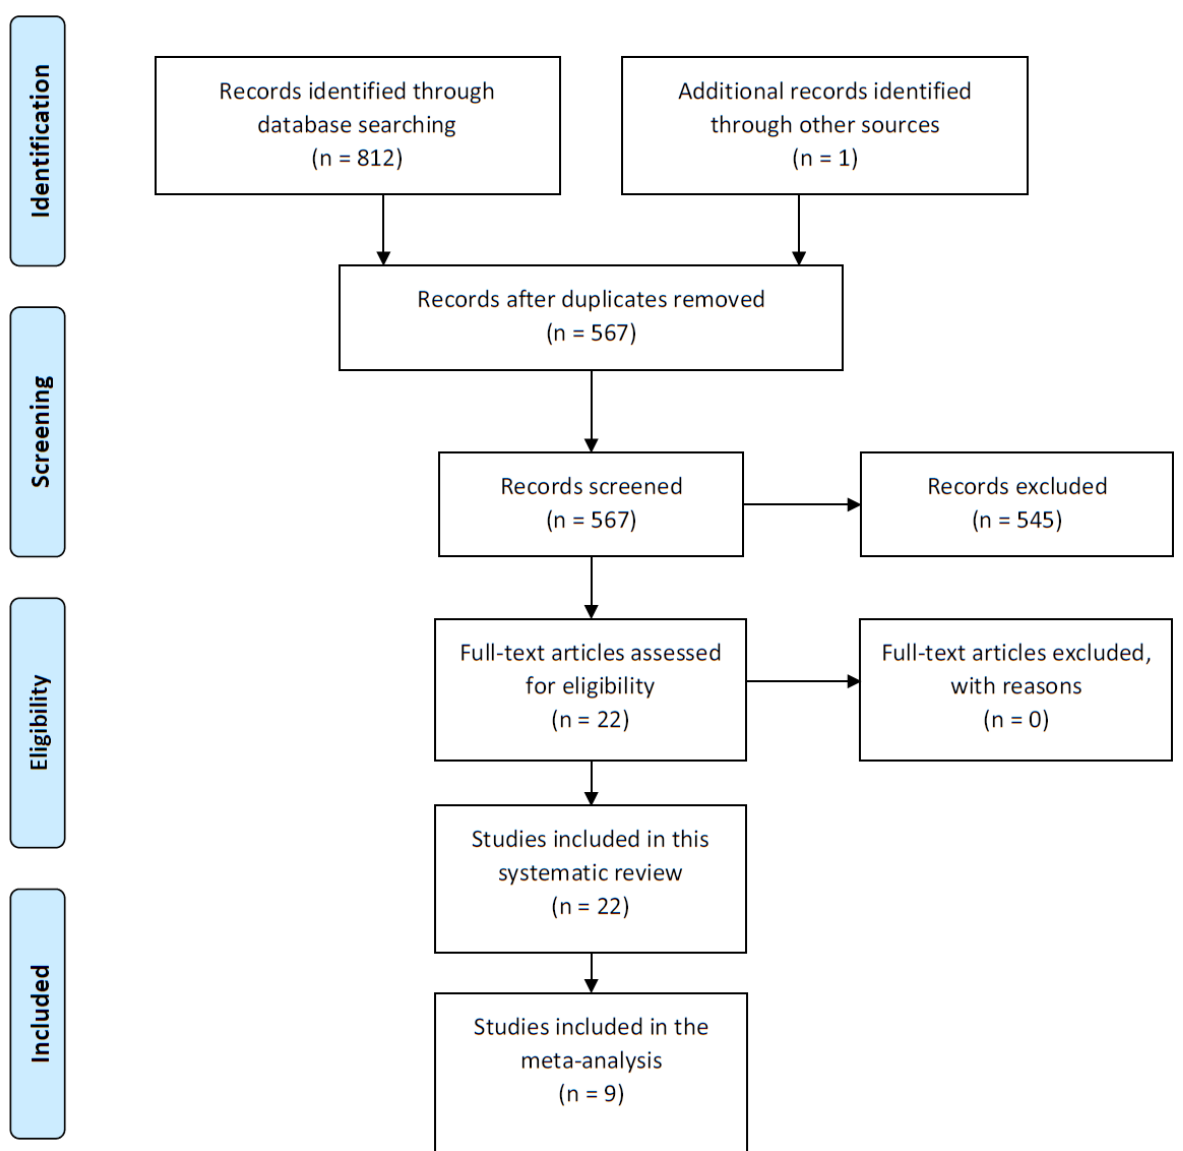
Figure 1. Systematic review PRISMA flow diagram.